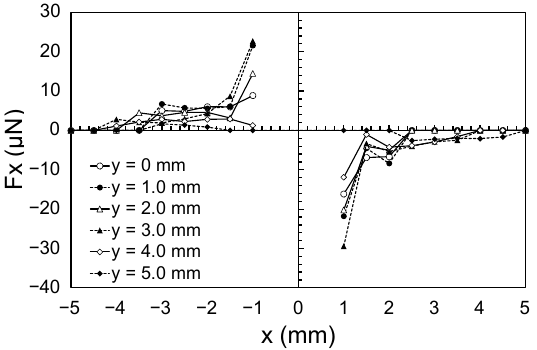
Figure 7. x-Component of the forces, F x at y = 0–5.0 mm.